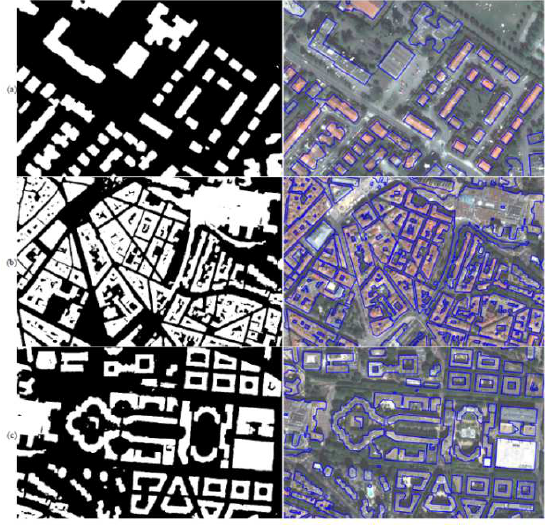
Figure 9: Building segmentation from U-Net RGBNir+DHM+NDVI+C3 and LOD0 regularization on (a) Toulouse and (b,c) Montpellier. Left: extracted buildings; right: True Ortho image with regularized building boundaries in blue